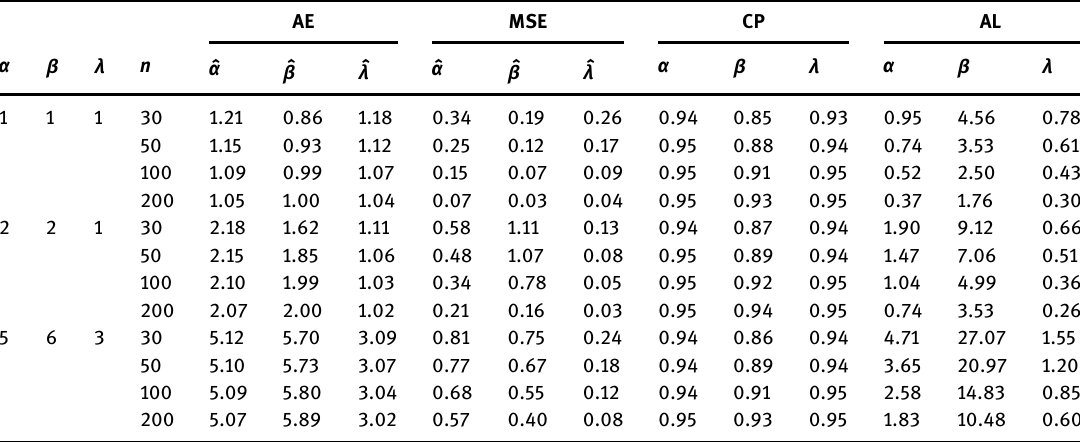
Table 1: Performance of MLEs and 95% con fi dence